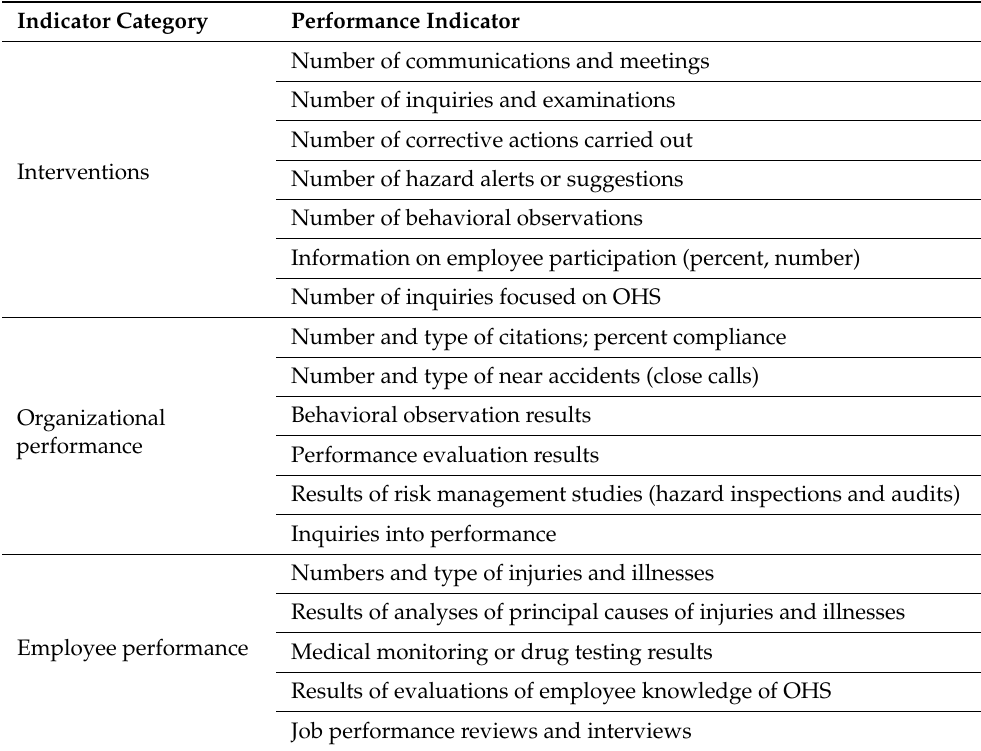
Table 11. Indicators used in the CORESafety OHS management tool